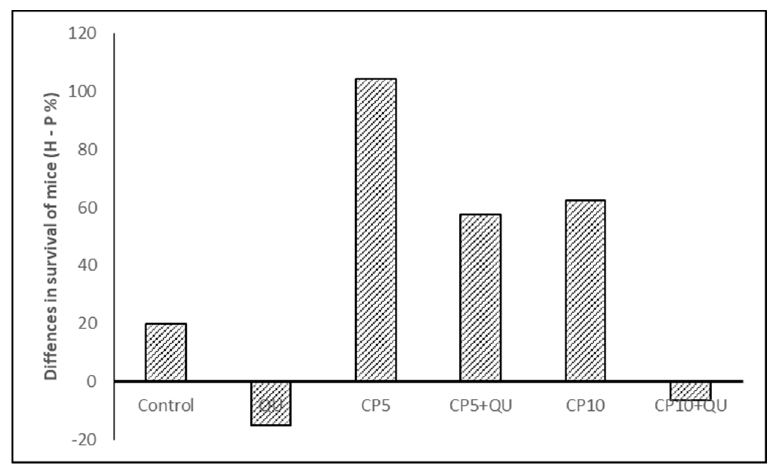
Figure 5. The di ff erence in the percentage of survival of Swiss albino mice bearing Ehrlich ascites tumor after therapeutic treatment with cisplatin (CP) and quercetin (QU) within the hyperthermic conditions in relation to physiological conditions. Abbreviation: QU—treatments with quercetin at dose of 50 mg kg − 1 ; CP5 or CP10—treatments with cisplatin at dose of 5 or 10 mg kg − 1 . Table 5. Combination index values of the interactions between the inhibitory e ff ect of quercetin and cisplatin under physiological and hyperthermic conditions on number of Ehrlich ascites tumor cells. Quercetin / Cisplatin Combination Physiological Conditions Hyperthermic Conditions Combination